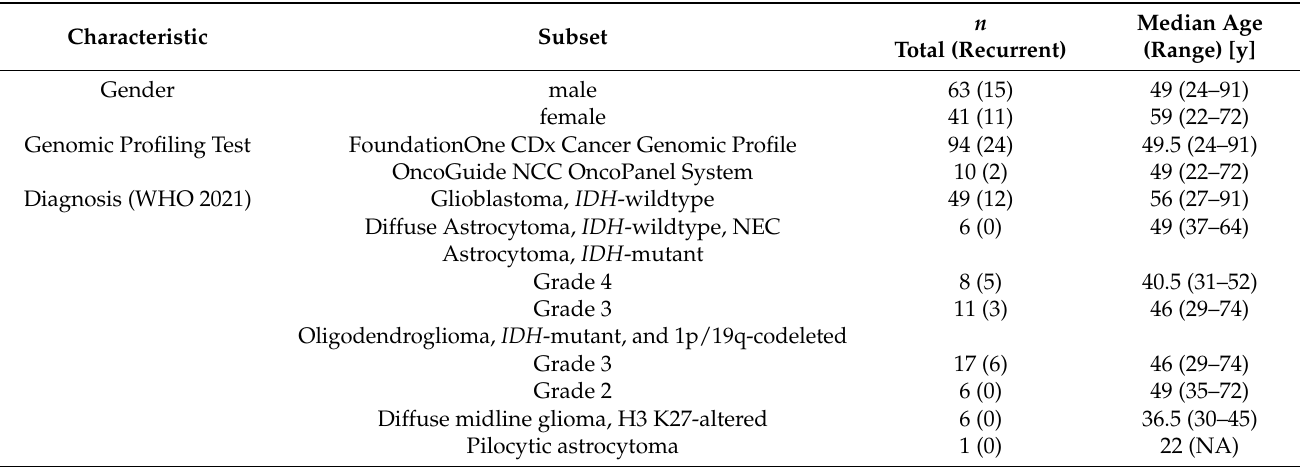
Table 1. Demographics of the enrolled patients with glioma who underwent genomic profiling test (CGPT). ( n =